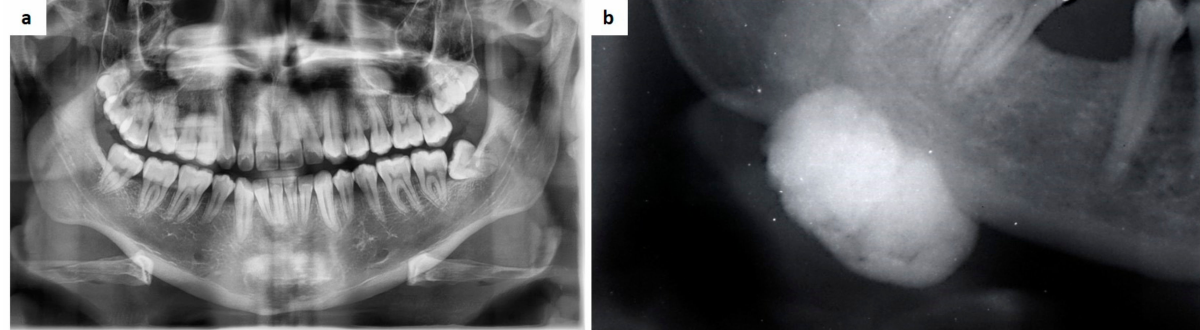
Figure 17. ( a , b ) Supernumerary teeth in the maxilla and multiple focal increases of bone density may represent the early clues of an undiagnosed Gardner syndrome especially in young ( a ); large mandibular osteoma in an already diagnosed patient ( b